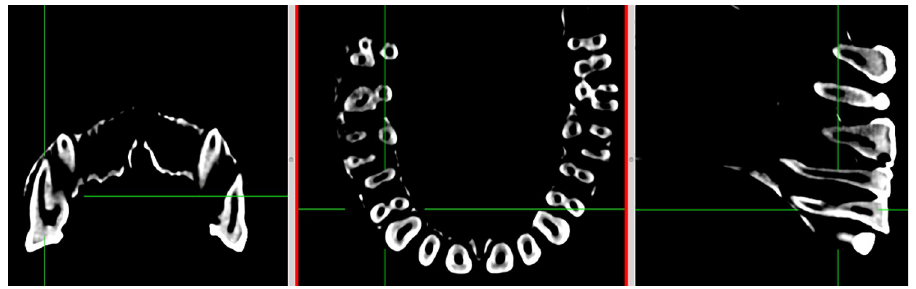
Fig 7. Horos Dicom Viewer 2D orthogonal view used to assess root and canal morphologies. Left: Coronal view at mid-point of roots. Centre: Anterior view at midpoint of roots. Right: Lateral view at midpoint of roots.